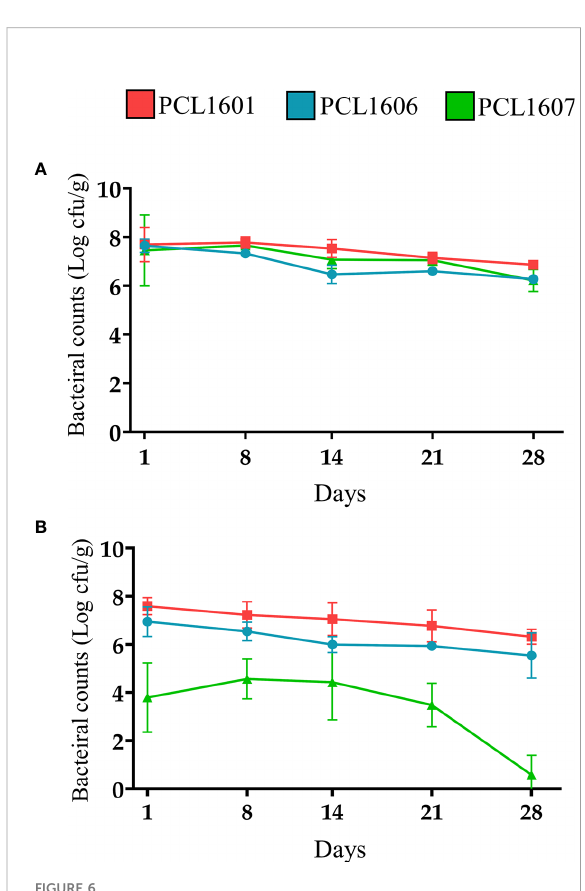
FIGURE 5 Competitiveness of Pc strains in avocado plant root assays. The competitive index in plant roots was calculated after 24 h of incubation. P. chlororaphis PCL1601 (red); P. chlororaphis PCL1606 (blue); P. chlororaphis subsp. piscium PCL1607 (red); 3P: combination of three Pc strains. Average competitive index (bar) and standard error (error bars) of three independent experiments are presented.